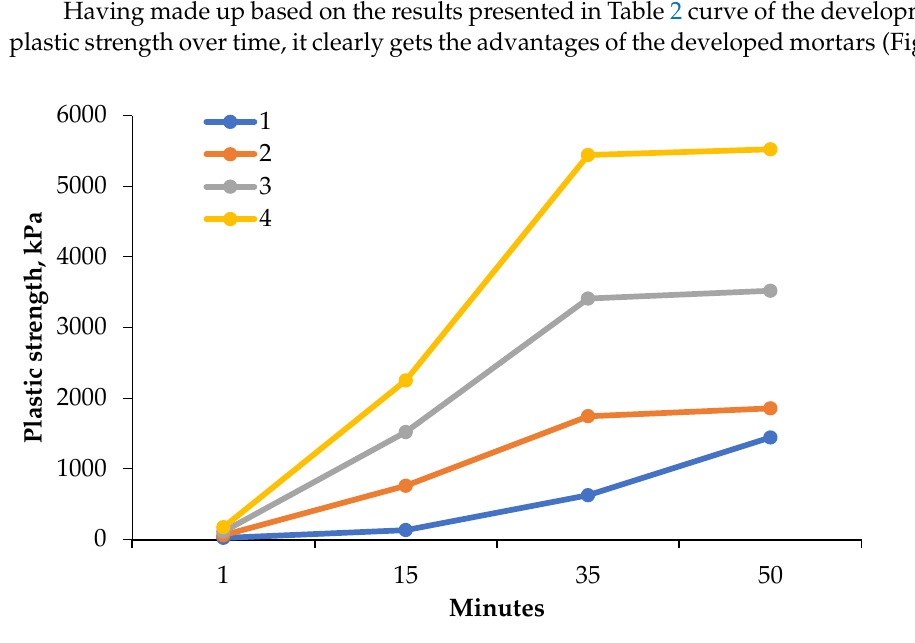
Figure 8. Development of plastic strength over time.